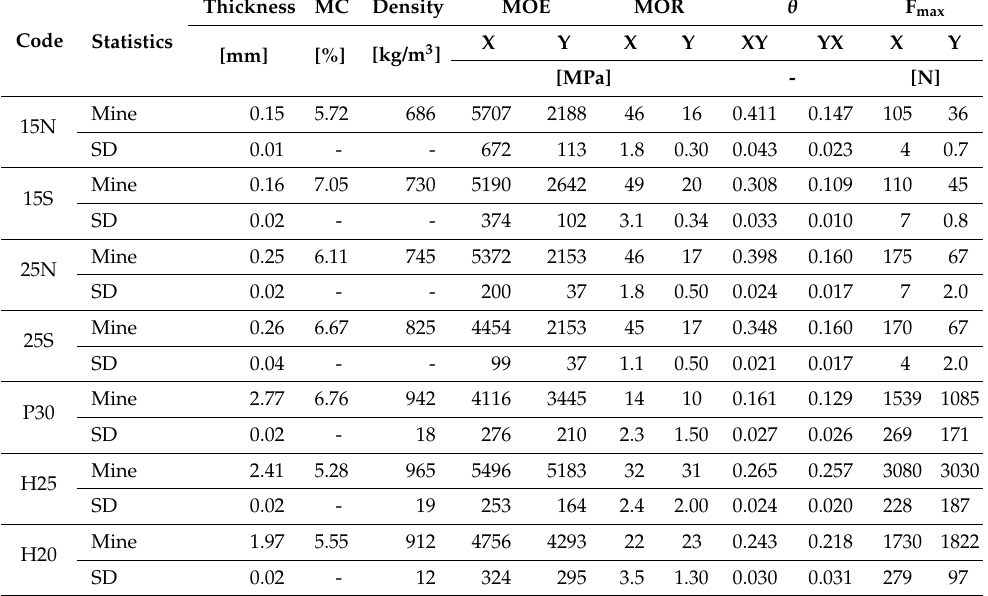
Table 2. Physical and mechanical properties of the materials used (MOE —modulus of linear elasticity, MOR —modulus of rupture, θ –Poisson’s ratio, F max —maximal destructive force, X, Y—orthotropy directions, MC—moisture content, SD—standard